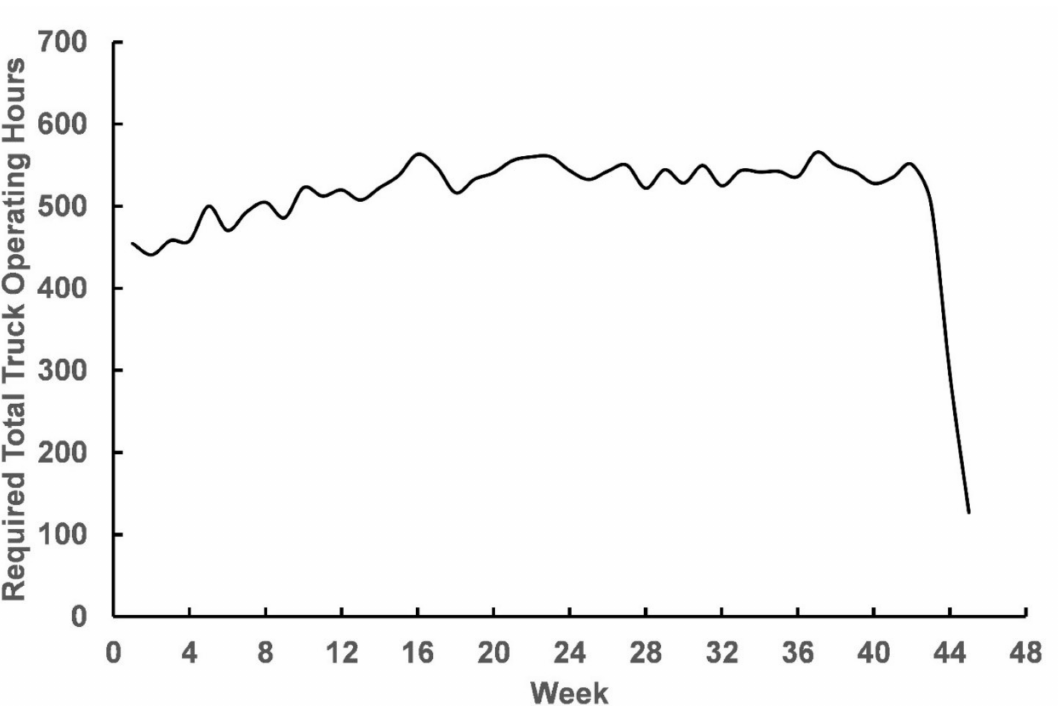
Figure 8. Required weekly truck fleet operating hours over the 46-week season of the nine-load-out simulation.